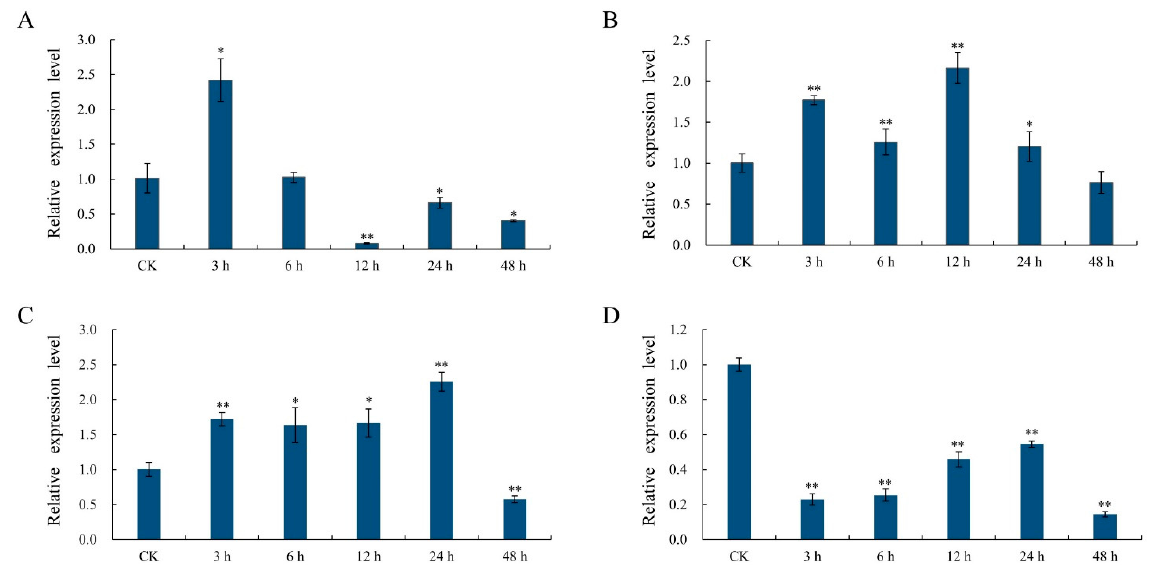
8 of 17 Figure 7. Expression analysis of GhSBPase gene in different tissues ( A ) and yellow-green leaf mutant ( B ) of cotton. ** p < 0.01. 2.8. Analysis of the Response of the GhSBPase Gene to Abiotic Stress The expression pattern of the GhSBPase gene under different abiotic stress conditions was analyzed, and the results demonstrated that the GhSBPase gene expression was in- duced in response to adverse stress, with different expression patterns under different stress conditions. Under drought stress, the GhSBPase gene expression was significantly up-regulated to the highest level at 3 h of treatment and then declined with prolonged treatment time (Figure 8A). Under salt stress, GhSBPase gene expression was significantly up-regulated to the highest level at 12 h of treatment, followed by a decrease to its lowest level at 48 h of treatment (Figure 8B). Under low-temperature stress, the GhSBPase gene